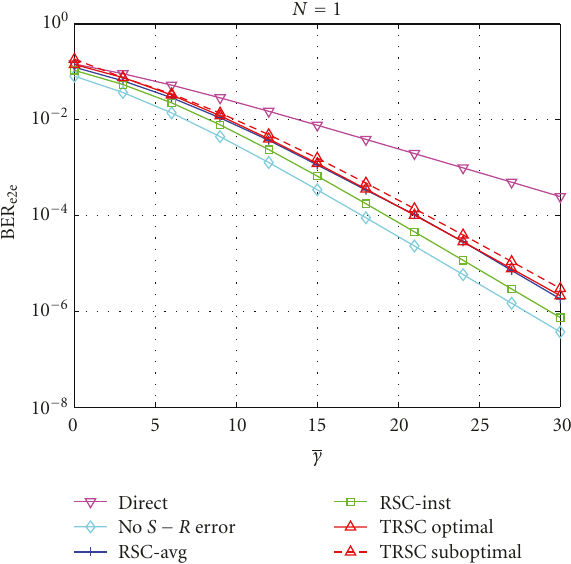
Figure 2: The e2e BER for all relaying protocols for N = 1 relay. The BER of direct transmission and the BER in the absence of errors in the S − R i links are also shown as reference curves.